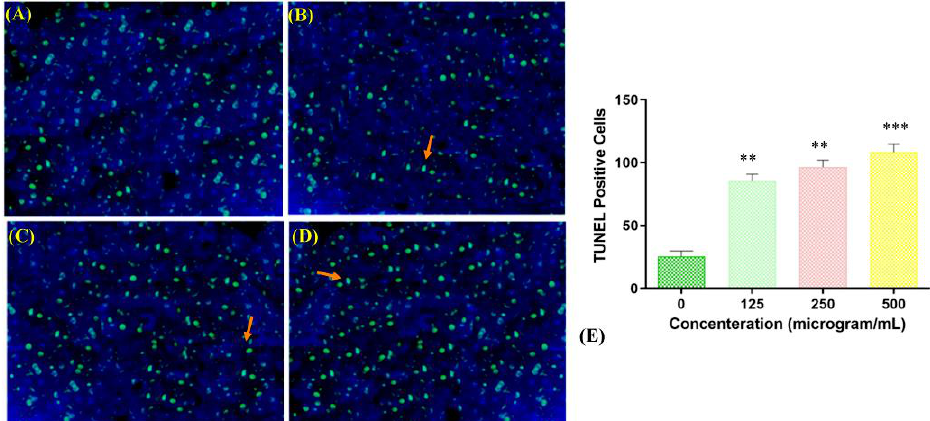
Figure 7. TUNEL-positive apoptotic A549 cells stained green, as indicated by arrows, for the nega- tive control and different dosages of the copper – Schiff base complex exposed for 24 h. Ethidium bromide (C 21 H 20 BrN 3 )-stained micrograph image of DMSO-treated cells (negative control) showing the regular growth of cells ( A ); copper complex-treated A549 cells treated with dosages (µg/mL) of 125 ( B ), 250 ( C ), and 500 ( D ). A significant increase in TUNEL-positive apoptotic A549 cells was observed when treated with the 500 µg/mL dosage of the copper – Schiff base complex. ( E ) The TUNEL-positive cells were treated with the copper – Schiff base complex at different concentrations compared with the negative control. Data are expressed as the mean ± SD ( n = 3). ** p < 0.01; *** p < 0.001 when compared to control.